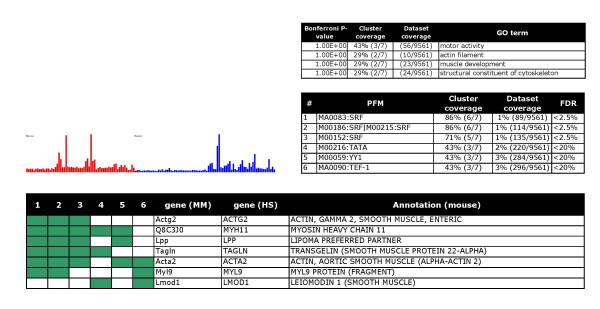
A smooth muscle differentiation battery: The bar chart (left) illustrates the average expression level of cluster members (Y axis) across arbitrarily ordered tissues (X axis) in two species (red = mouse and blue = human). Three tables list over-represented functional terms (upper small table), over represented motifs (PFMs) (middle table), and cluster members (lower table).